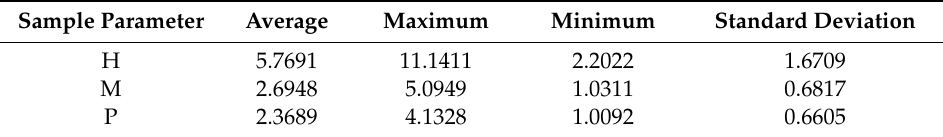
Table 3. LM statistical results of the three types of